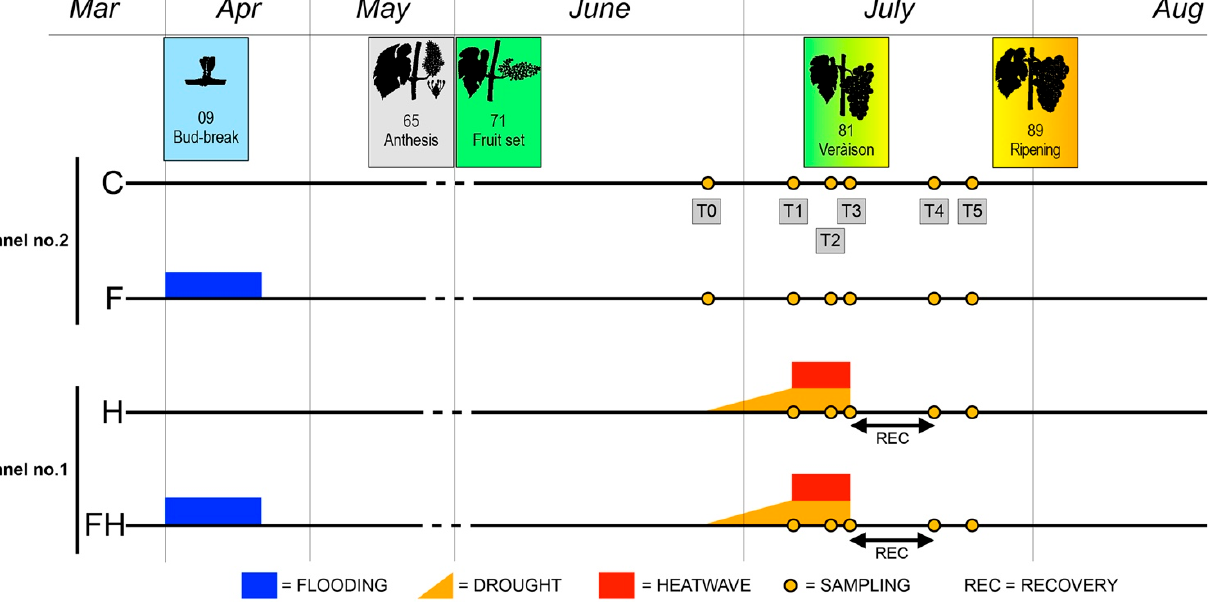
Figure 12. Schematic representation of the experimental set ‐ up. The months of the year are reported at the top, with the key phenological stages indicated below (BBCH scale; [44]). The four experimental treatments (C, control; F, spring flooding; H, summer heatwave; FH, spring flooding + summer heatwave) are shown as separate lines, along with the key time points for sample collection, with the indication of the tunnel to which they belong on the left. The legend on the bottom describes the colors used in the scheme.